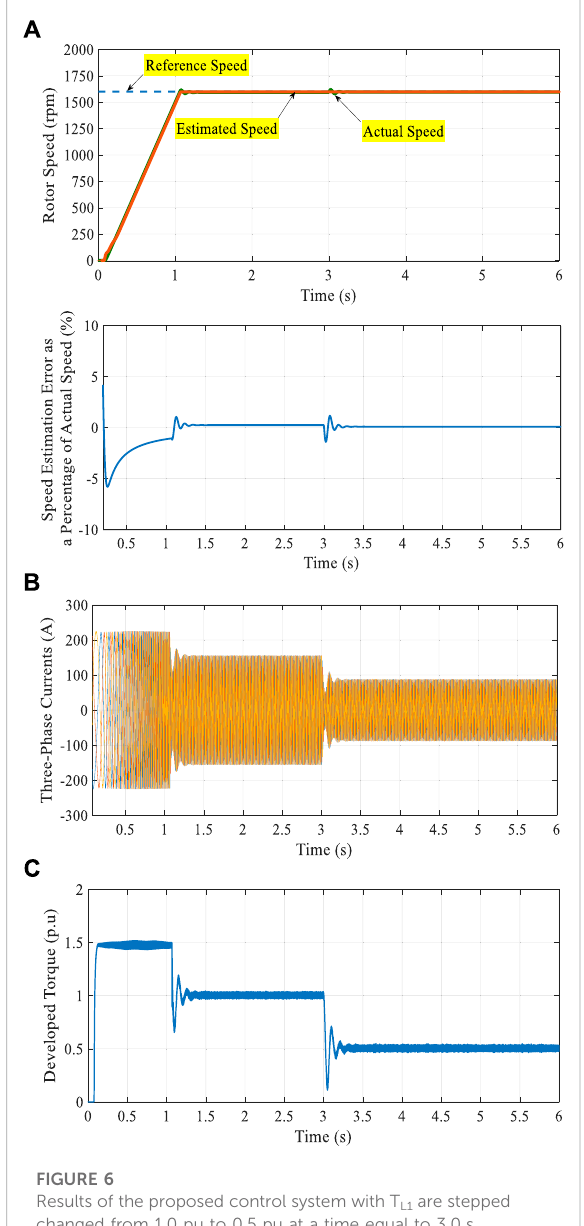
FIGURE 5 Results of the proposed control system with T L1 equal to 1.0 pu and ramped changes of the reference speed.